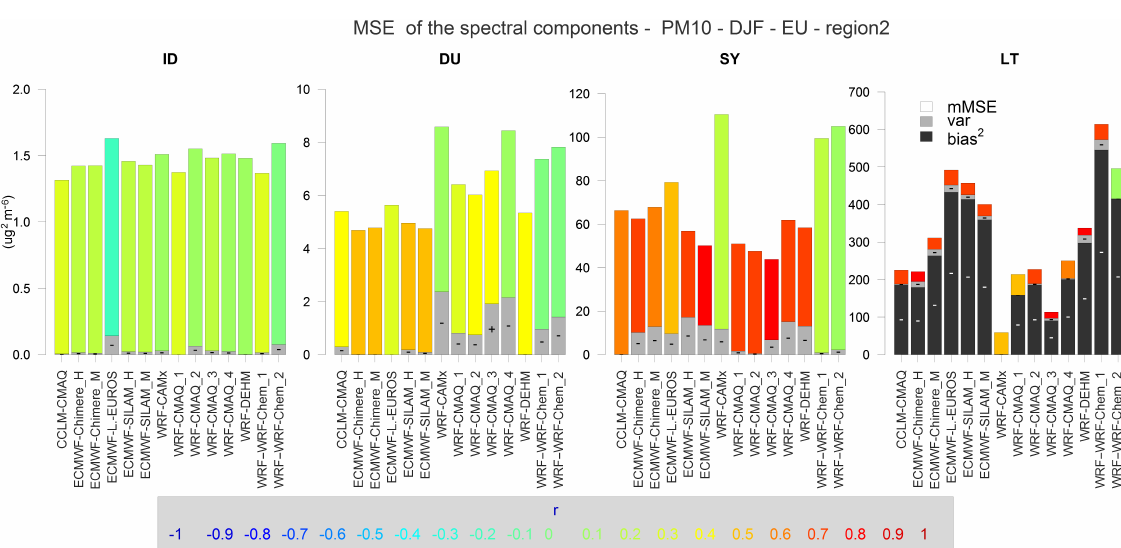
Figure 26. As in Fig. 10 but for PM 10 in Europe (error units in µgm − 3 )